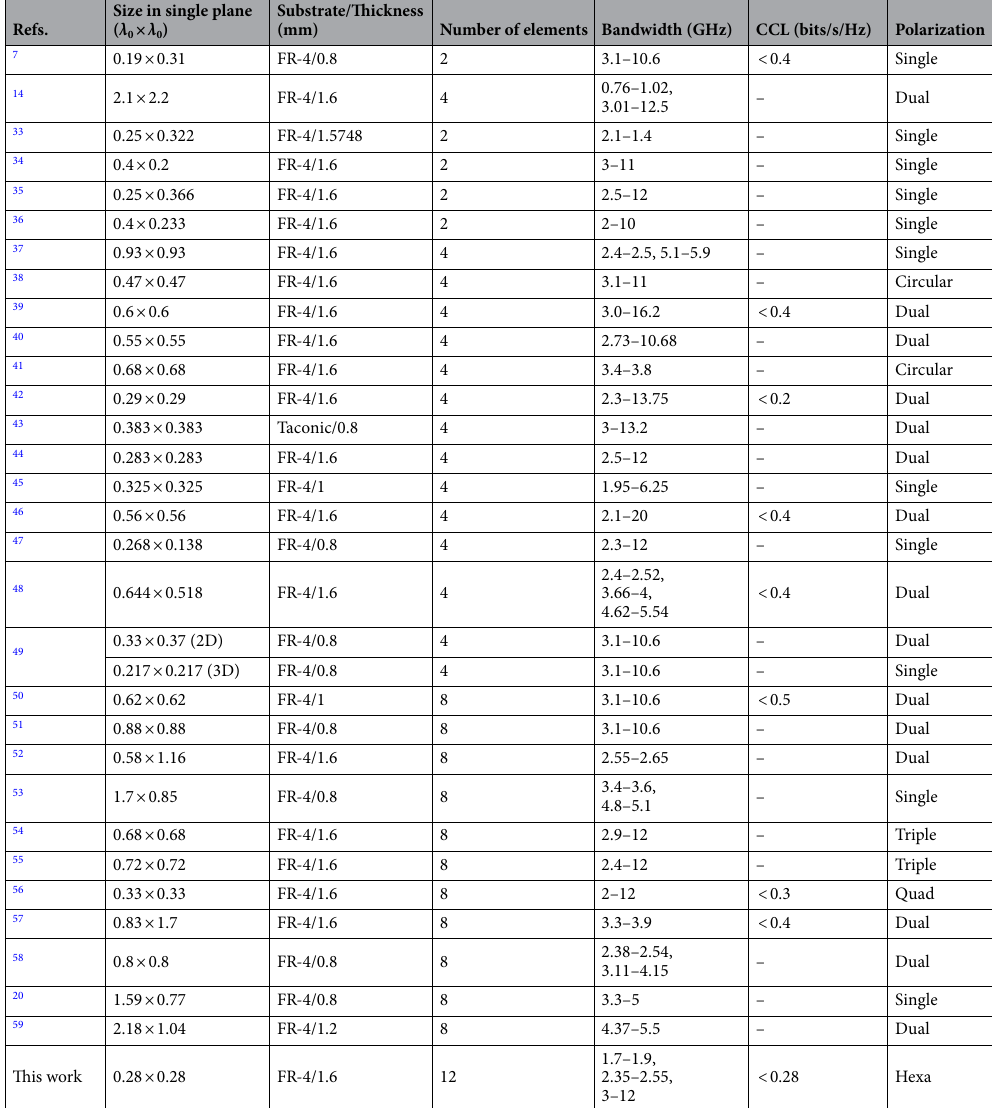
Table 5. Comparison of the proposed work to previous